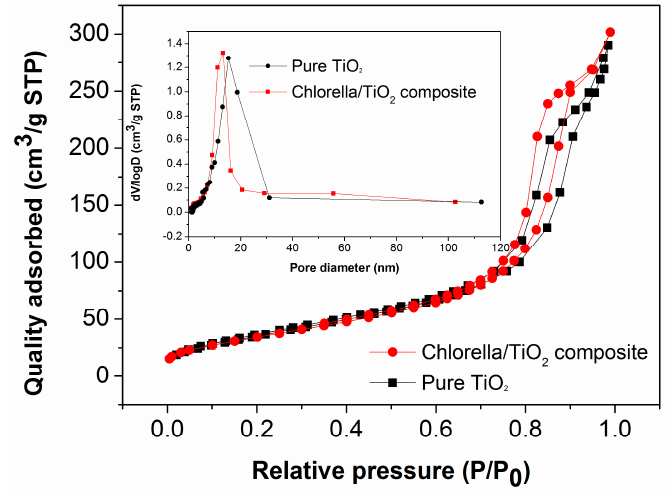
Figure 4. UV-vis diffuse reflectance spectra (DRS) of the chlorella/TiO 2 composite and the pure TiO 2 .